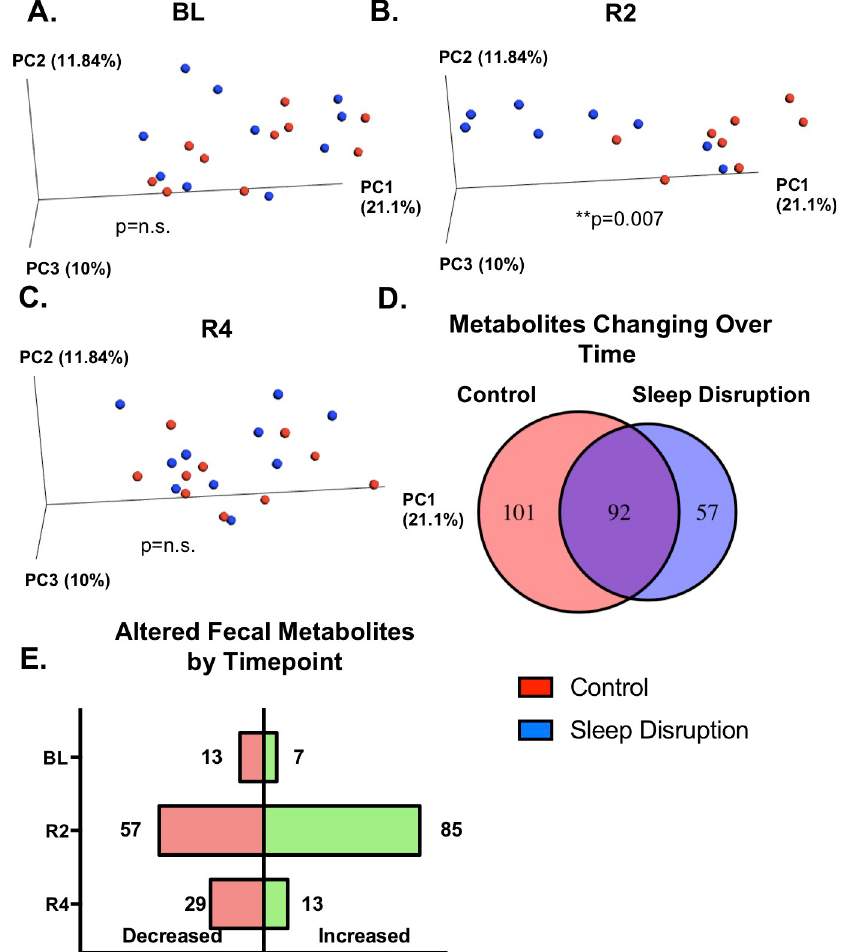
Fig 5. Effect of sleep disruption on the fecal metabolome. A,B,C) Principal coordinates analysis (PCoA) plots using Bray Curtis distance. PERMANOVA detected a significant difference between sleep disruption and control groups day 2 post-sleep disruption, but not BL or at day 4 post-sleep disruption. D) Kruskal-Wallace tests were run within the control group and within the sleep disruption group to determine metabolites significantly changing over the course of the experiment (FDR < 0.1). The number of metabolites found to have an effect of time only in the control group (left number), an effect of time only in the sleep-disrupted group (right number), or in both groups (middle number) is depicted in the Venn diagram. E) Wilcoxon Rank-Sum tests were performed at each timepoint to quantify the number of metabolites increased (right, green bars) or decreased (left, pink bars) in the sleep disruption group at each timepoint (uncorrected p < 0.05). Abbreviations: BL, baseline; R2, day 2 post-sleep disruption; R4, day 4 post-sleep disruption. n = 8-10/group. �� p < 0.01